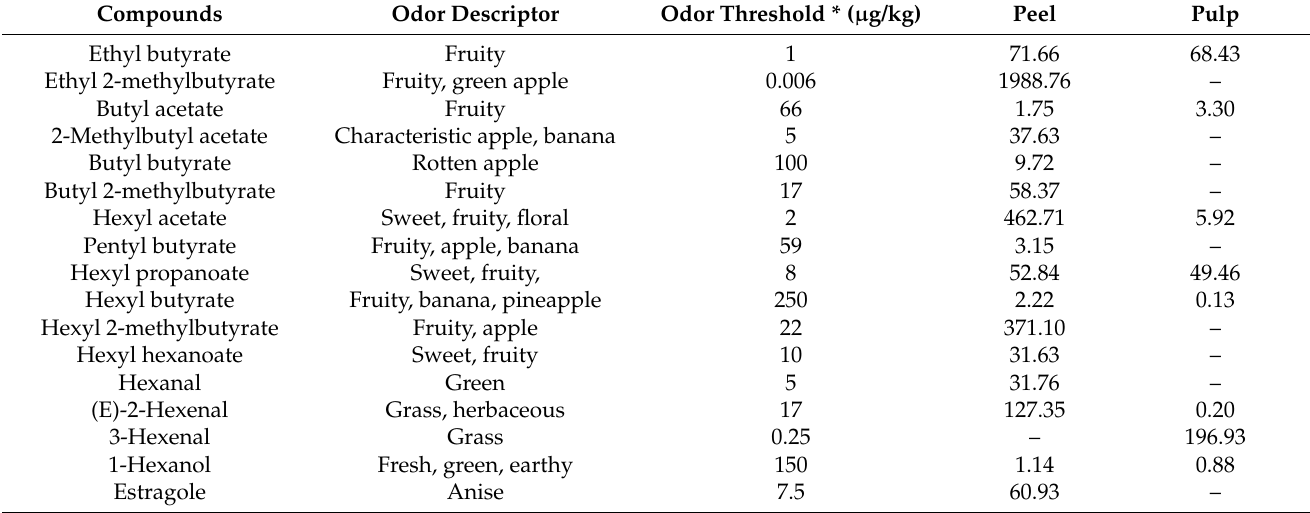
Table 7. Odor activity values of volatile compounds reaching a concentration above the odor threshold (OAV > 1) in ‘Orin’ apple peels and pulps at the 180 DAFB